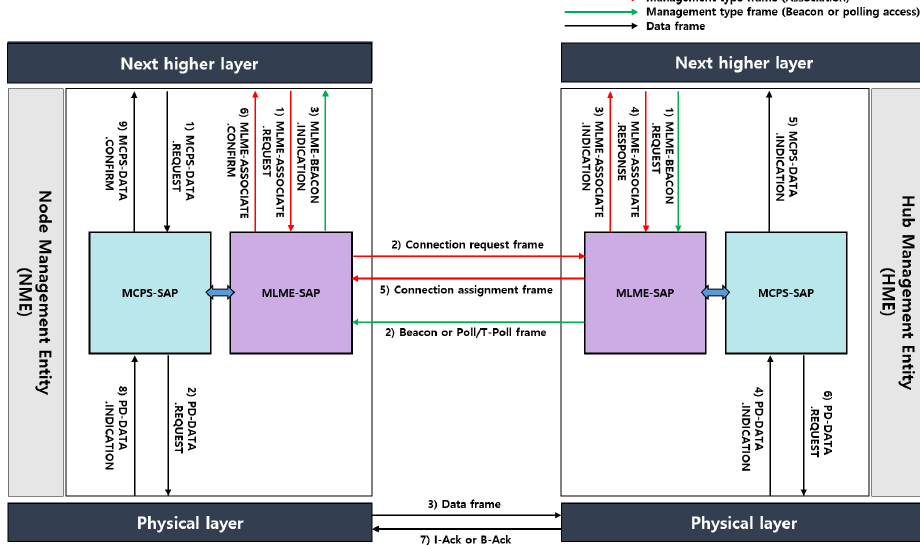
Figure 6. Design of IEEE 802.15.6 MAC on